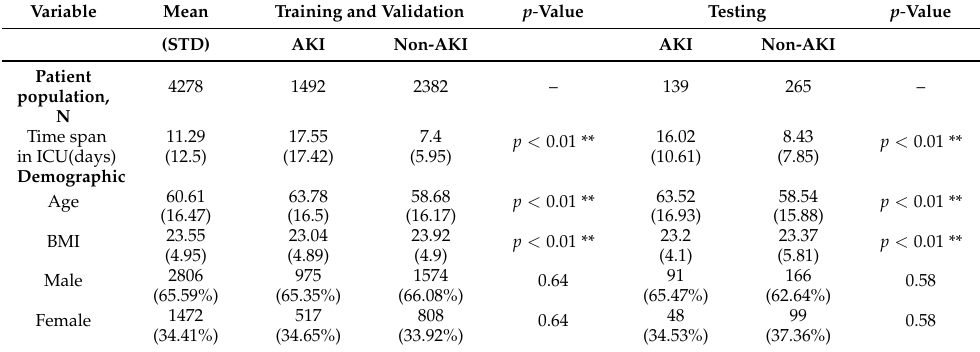
Table 5. Cohort Analysis of Patient Population and Demographics.